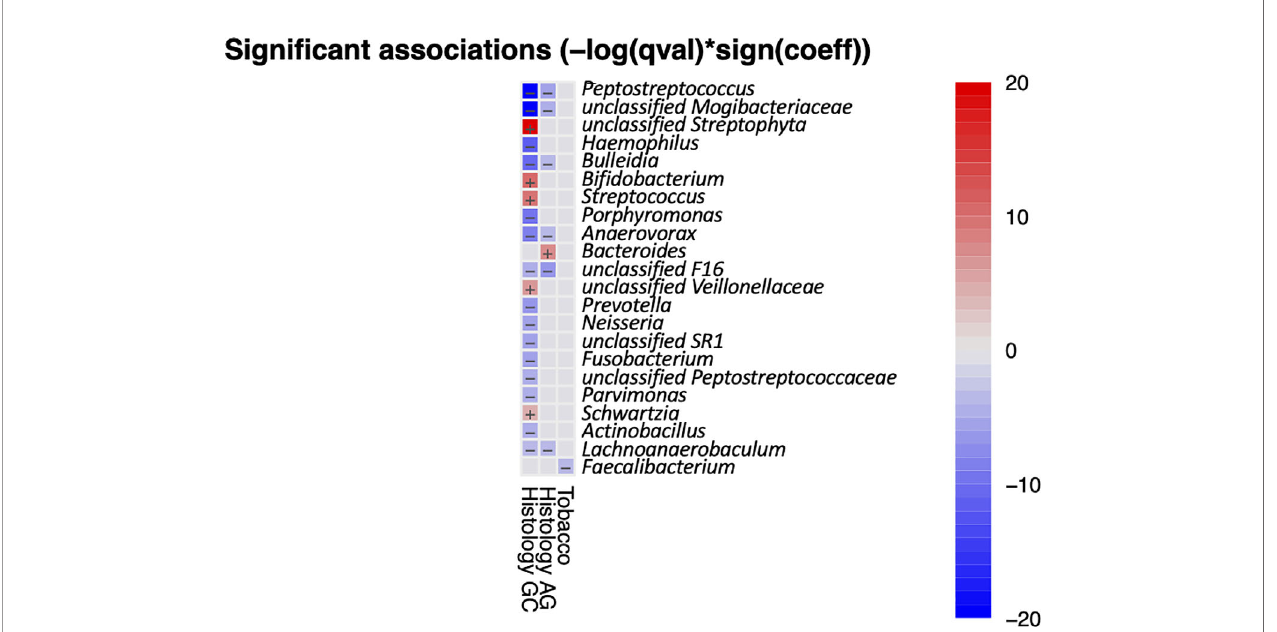
FIGURE 3 | Heatmap summarizing the signi fi cant associations between oral bacteria and metadata. Color key: -log(q-value)*sign(coef fi cient). Cells that denote signi fi cant associations are colored (red or blue) and overlaid with a plus (+) or minus ( − ) sign that indicates the direction of association.